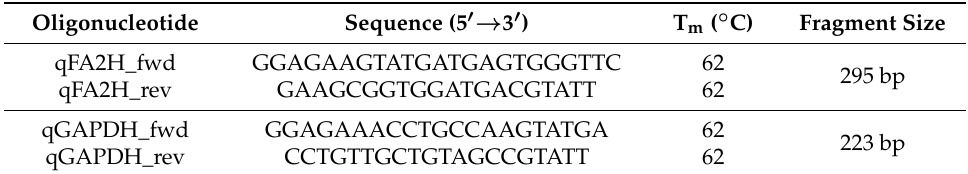
Table 1. Oligonucleotides used for qPCR. FA2H = oligonucleotide for fa2h ; GAPDH = oligonucleotide for gapdh ; fwd = forward; rev = reverse; Tm = melting